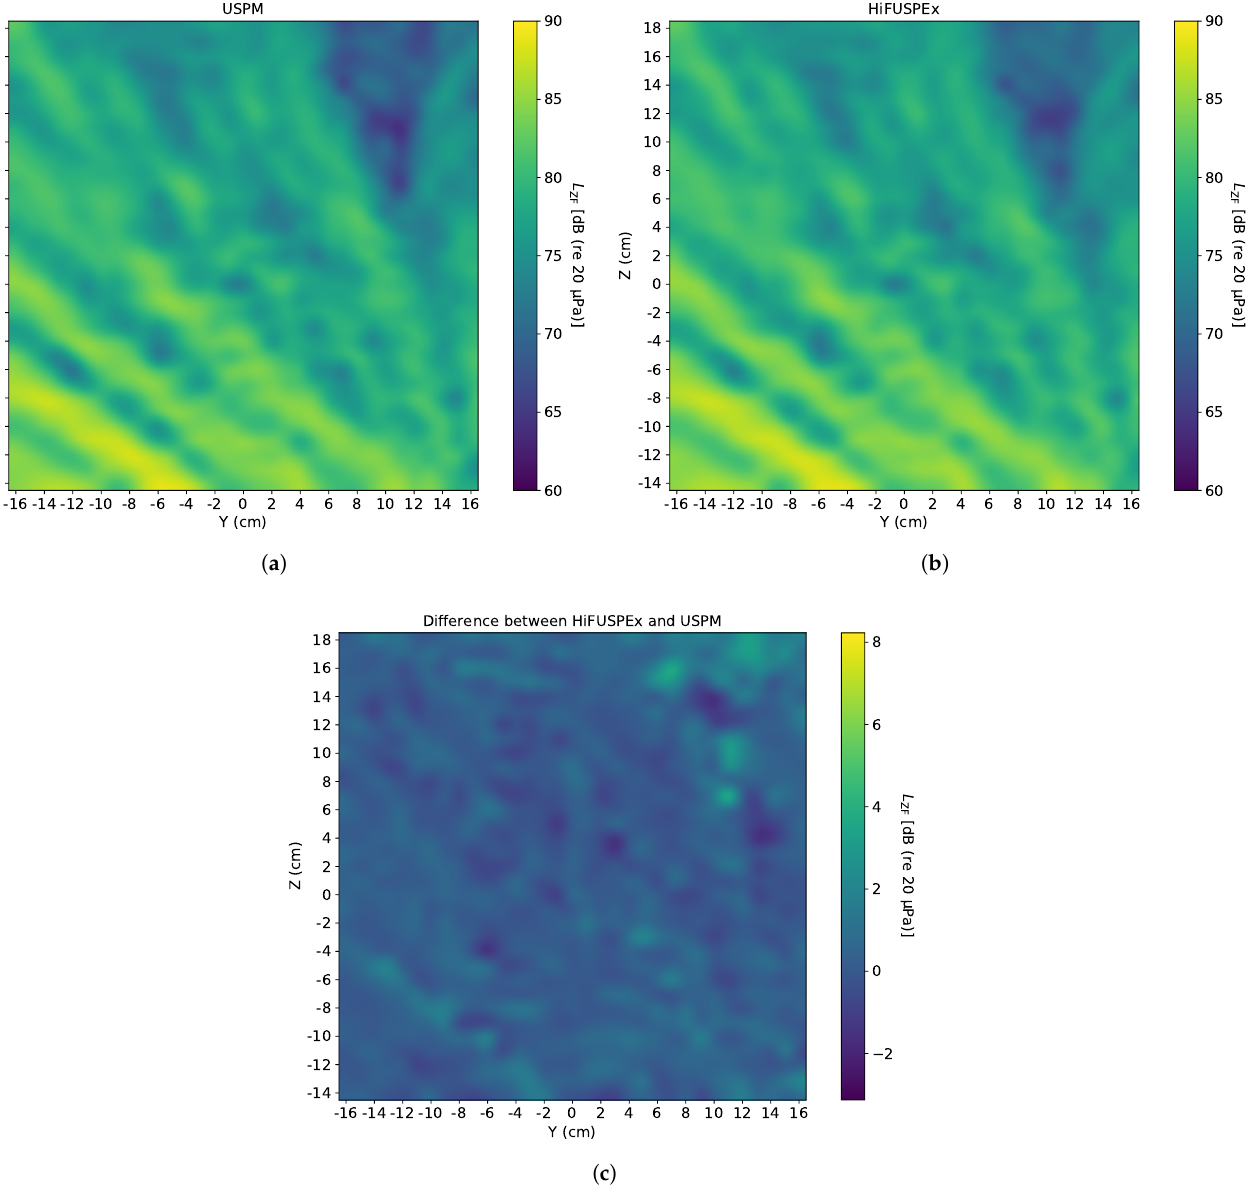
Figure 13. Sound fields within the scanning unit when an idealized signal of a welding machine (10 kHz + 20 kHz) was simulated. Results were obtained on the right-hand side with the artificial head in the sedentary position and without the protection grid mounted. The presented plots show the sound fields obtained for: ( a ) USPM; ( b ) HiFUSPEx; and ( c ) difference between the HiFUSPEx and the USPM. Please refer to Figure 10 for identification of zy